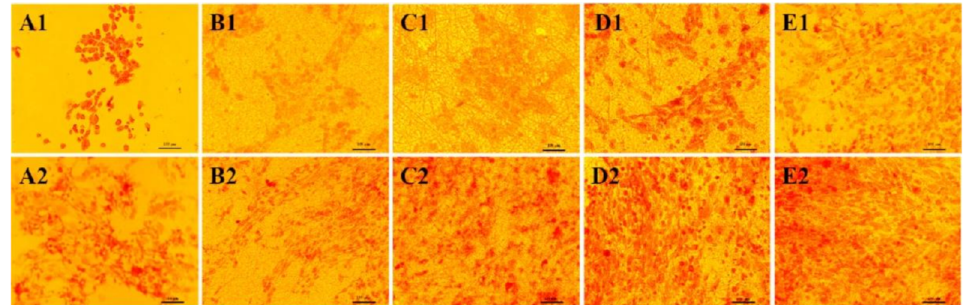
Figure 5. Alizarin Red-Staining (ARS) staining of osteoblasts on Tissue Culture Plates (TCPs) ( A1 , A2 ) and PHBV ( B1 , B2 ), PHBV/CTS ( C1 , C2 ), PHBV/CTS/nHA4 ( D1 , D2 ), PHBV/CTS/HA8 ( E1 , E2 ) scaffolds on days 5 ( A1 – E1 ) and 20 ( A2 – E2 ). Reprinted from [135] with permission from